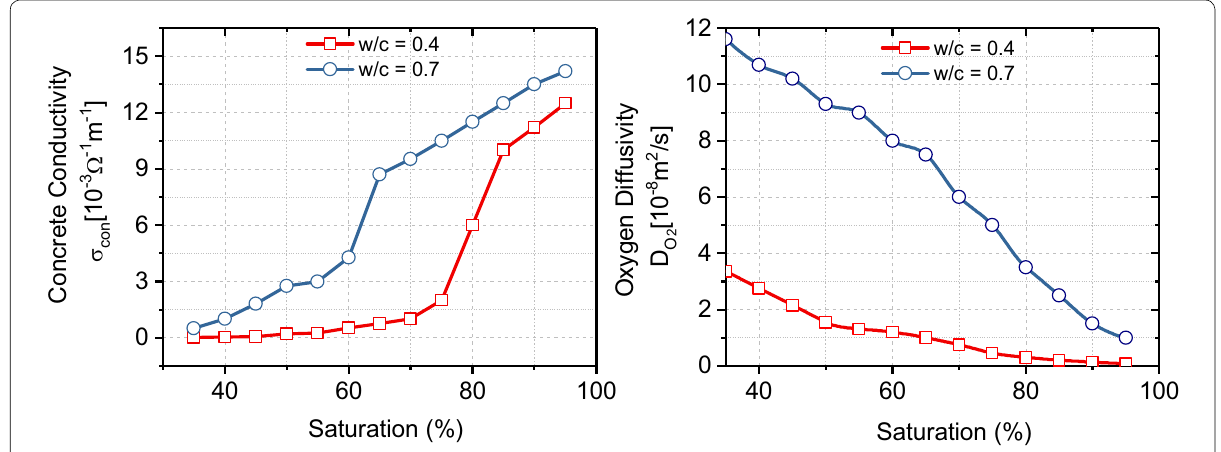
Fig. 3 Variation of concrete conductivity and oxygen diffusivity across varying levels of saturation (Balabanic et al. 1996).